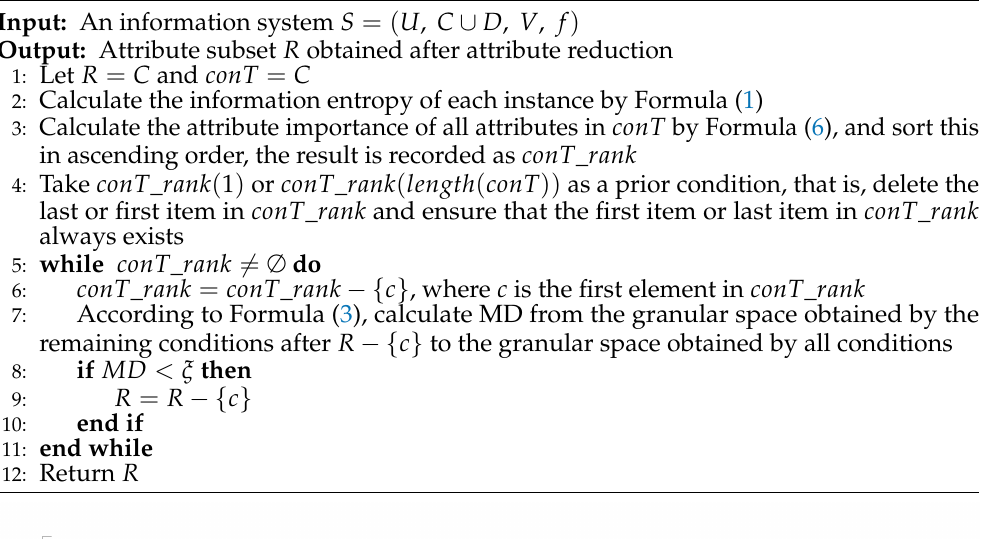
Algorithm 1 Attribute reduction based on relative MD